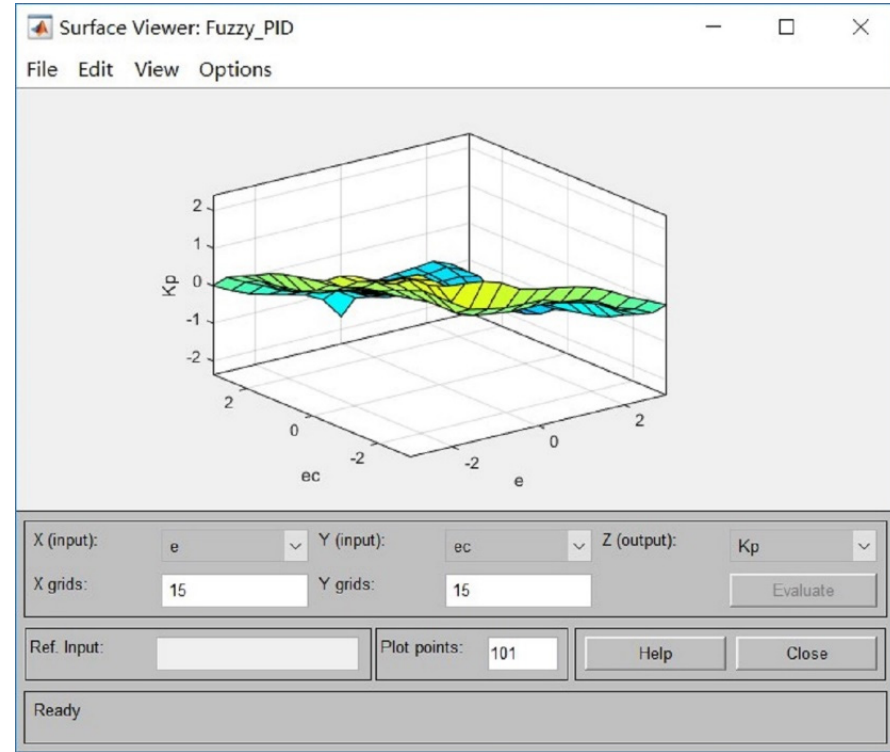
Figure 7. Kp regular surface.